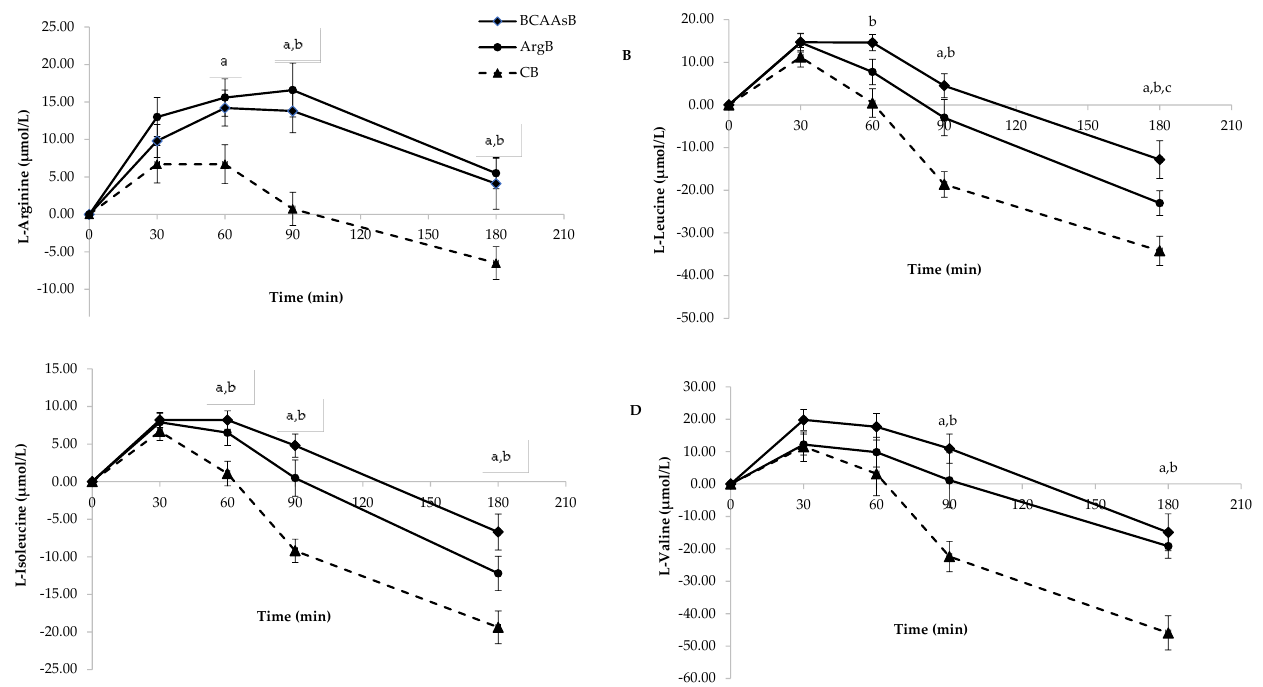
Figure 2. Responses of L-arginine ( A ), L-leucine ( B), L-isoleucine ( C ) and L-valine ( D ) of subjects 3 h after the consumption of the three tested biscuits. Values are expressed as mean ± SEM ( n = 30). a p < 0.05 between ArgB and CB, b p < 0.05 between BCAAsB and CB, c p < 0.05 between BCAAsB and ArgB.